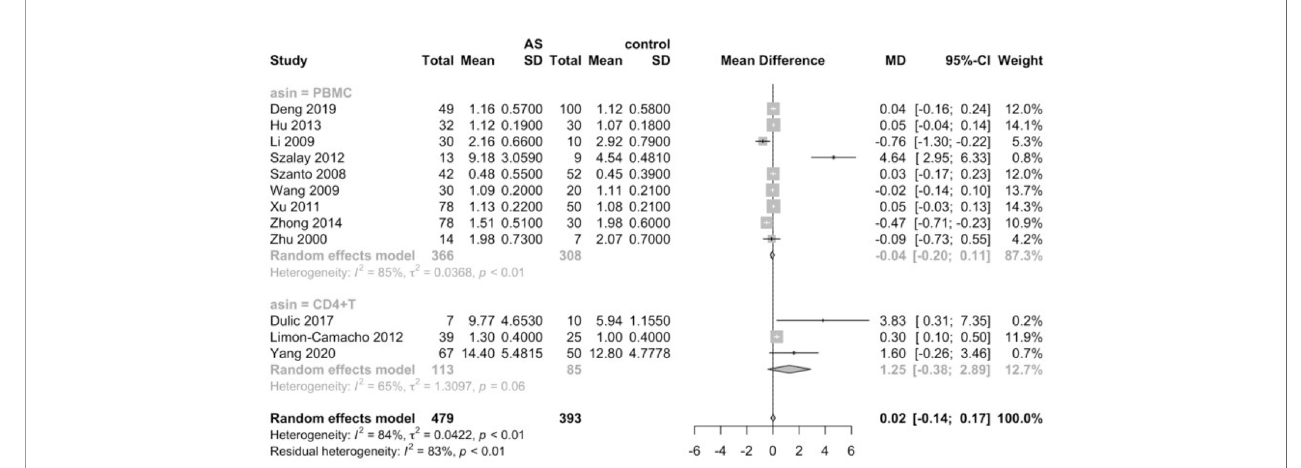
FIGURE 6 | Proportions of Th2 cells among PBMCs and CD4+